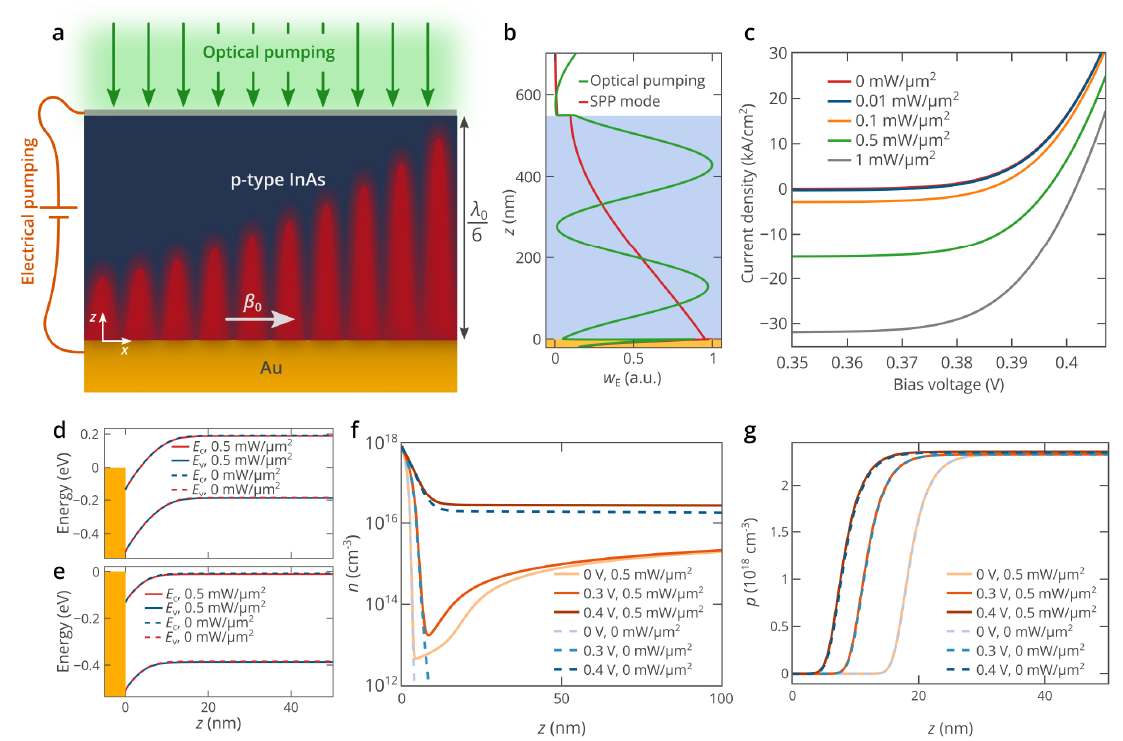
Figure 1. ( a ) Schematic illustration of surface plasmon polariton amplification in an electro-optically pumped active planar plasmonic waveguide, β 0 is the SPP wavevector and λ 0 is the free-space wavelength at which the SPP is excited. ( b ) Spatial distributions of the electric energy density of the SPP mode and the optical pump wave. The SPP is excited at a free space wavelength of 3.26 μm ( ε Au = −561 + 30 i [24], ε InAs = 12.8 [37]), while the wavelength of the pump wave is 2.07 μm ( ε Au = −225 + 7.8 i [24], ε InAs = 11.9 [37]). ( c ) Simulated current-voltage characteristics of the device shown in panel ( a ) at different optical pump power densities. ( d , e ) Energy band diagrams of the device at bias voltages of 0.2 V (panel ( d )) and 0.4 V (panel ( e )) in the vicinity of the Au/InAs interface in the absence and presence ( P pump = 0.5 mW/μm 2 ) of optical pumping. E c and E v denote the band edges of the conduction and valence bands, respectively. ( f , g ) Spatial distribution of the electron (panel ( f )) and hole (panel ( g )) densities in the vicinity of the Au/InAs interface at three bias voltages in the absence and presence ( P pump = 0.5 mW/μm 2 ) of optical pumping. Abbreviations: SPP, surface plasmon polariton.